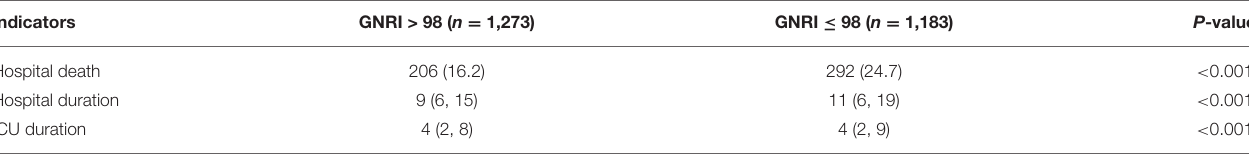
TABLE 5 | Comparison of hospitalization outcomes and prognosis of patients in malnutrition and normal nutrition groups. Indicators